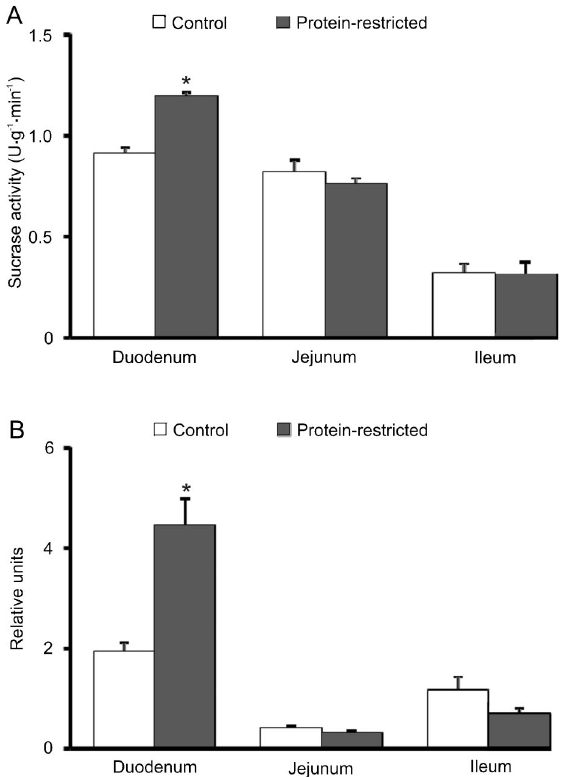
Figure 1. Lactase activity ( A ) and lactase mRNA abundance ( B ) in the intestine of 3-week-old rats (n = 5-8 animals) born to dams fed a protein-restricted (6% protein) or a control diet (17% protein). Data are reported as means ± SE. *P , 0.05 compared to control (Student t -test). distal intestine. PR16 rats had higher sucrase activity in the duodenum compared to C16 (Figure 2). However, maltase activity did not differ between PR16 and C16 in the proximal, middle or distal intestinal segments.